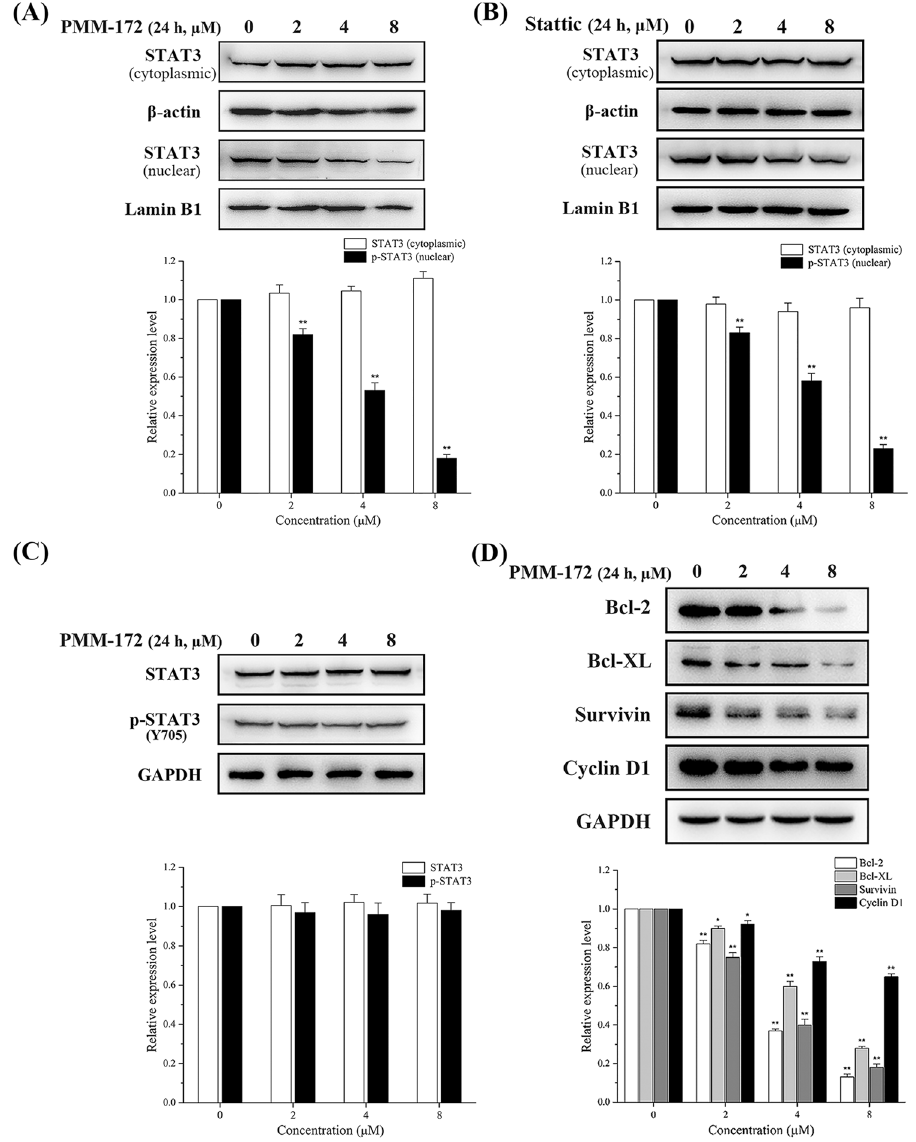
Figure 7. MDA-MB-231 cells were treated with indicated concentrations of PMM-172 or Stattic for 24 h, the expression levels of STAT3 in cytoplasmic and nuclear extracts were examined and relative expression levels were analyzed by Image J software. β -actin and Lamin B1 served as markers of cytoplasmic and nuclear extractions, respectively. ( A ) PMM-172 suppressed STAT3 nuclear localization. ( B ) Stattic suppressed STAT3 nuclear localization. ( C ) MCF-10A cells were treated with the indicated concentrations of PMM-172 for 24 h. PMM-172 had no effect on the level of the pSTAT3 level in MCF-10A cells. ( D ) PMM-172 down-regulated the expression of STAT3 target genes. Data were shown as mean ± SD from three independent experiments, ** P < 0.01. Cropped blots/gels were used in the figure and the gels had been run under the same experimental conditions; the full-length blots/gels are presented in Supplementary Figure